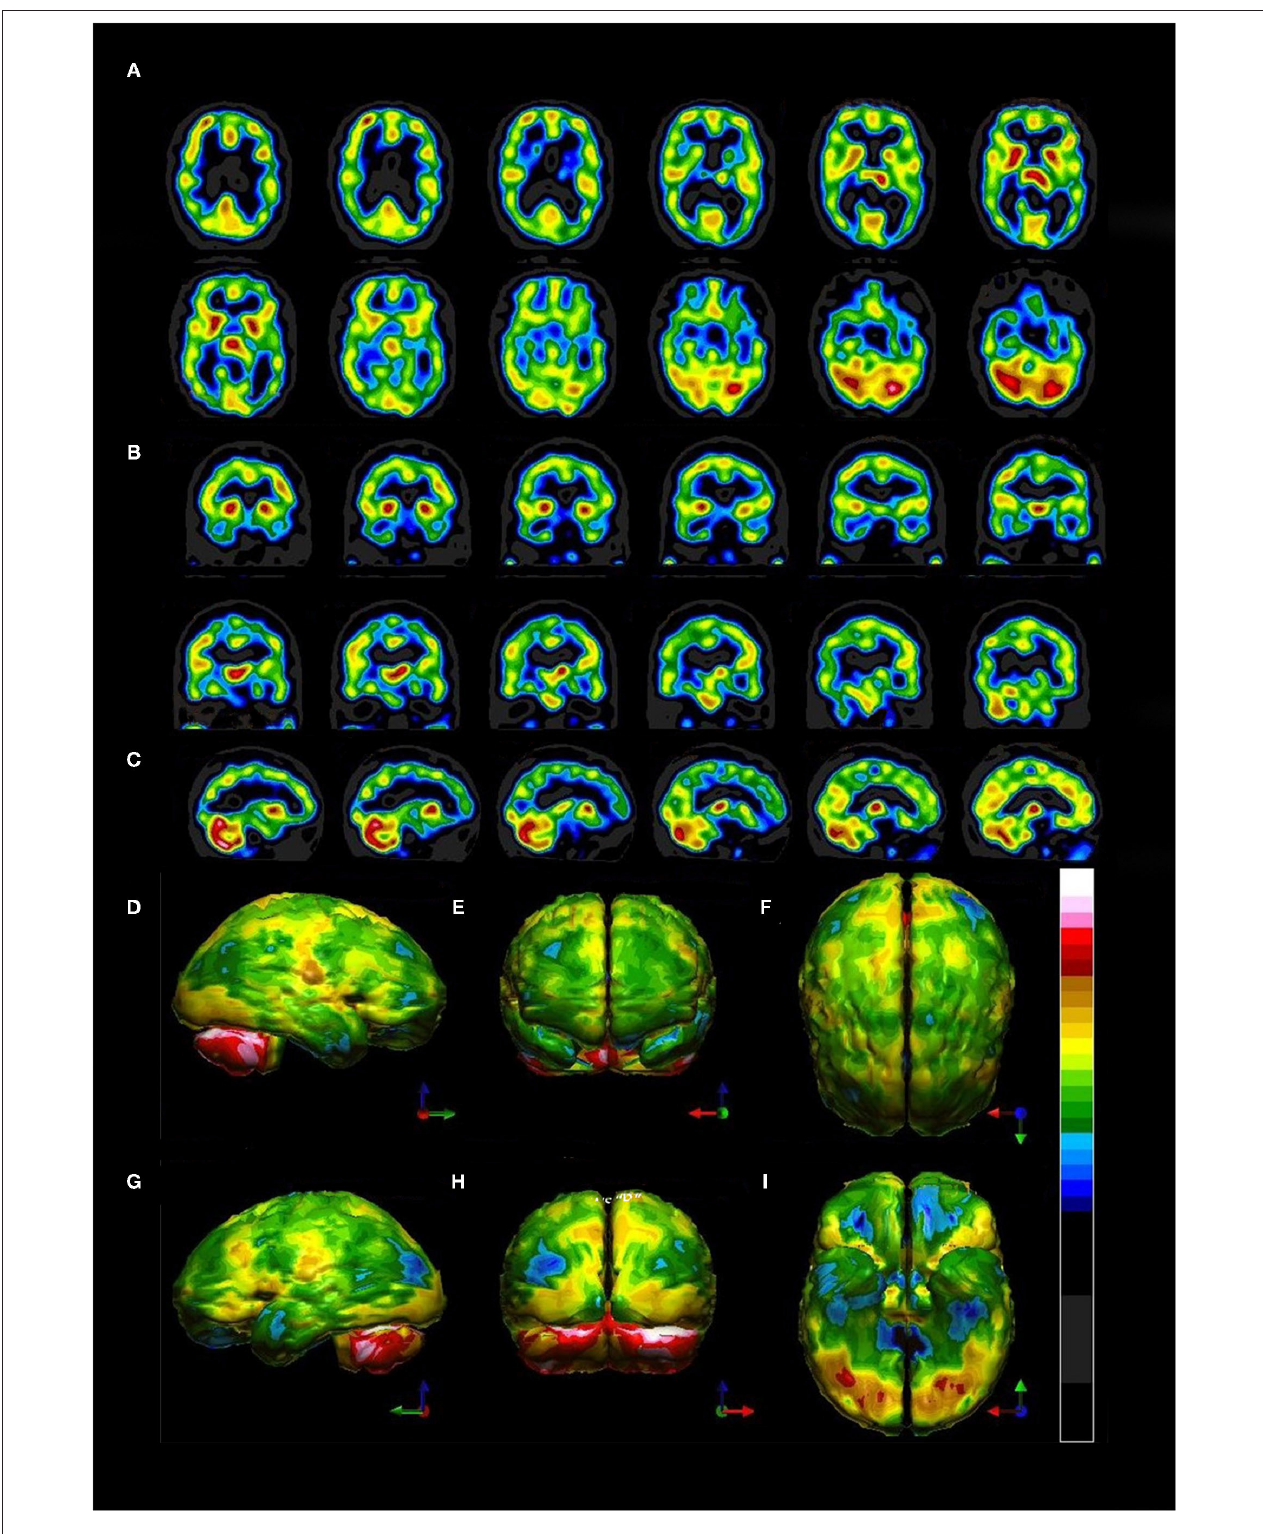
FIGURE 11 | Tomograms and 3-D surface projections of perfusion SPECT scan showing diffuse hypoperfusion. (A) Selected transverse sections. Of note, the thalamus is neither hyper-perfused nor asymmetrical as is typically seen in bipolar disorder. (B) Selected coronal sections. The thalamus can be seen in a different orientation and is neither hyper-perfused nor asymmetrical. (C) Selected sagittal sections. (D–I) 3-D surface projection views show the highly difuse nature of the hypoperfusion involving frontal, temporal, parietal, and even occipital cortices. (D) Left lateral view. (E) Anterior view. (F) Superior view. (G) Right lateral view. (H) Posterior view. (I) Inferior view with cerebellum removed. Color scale is the Ubiq40 color scale as described in Figure 5 .